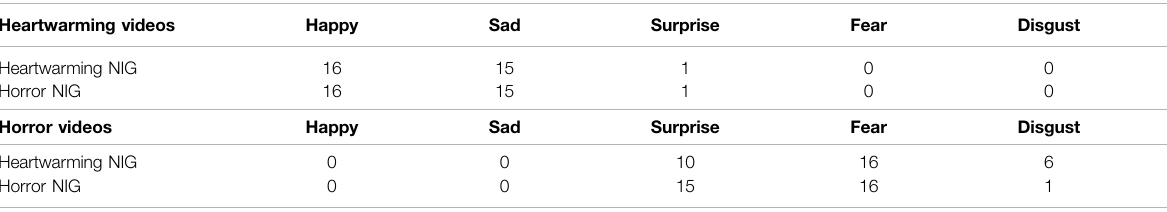
TABLE 1 | Perceived emotion from robot ’ s touch.